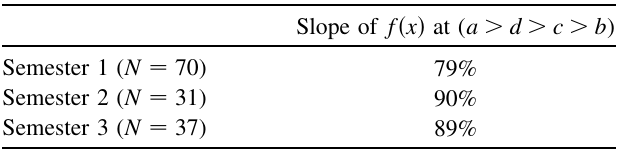
TABLE I. Student performance on slope ranking task, by semester of administration.